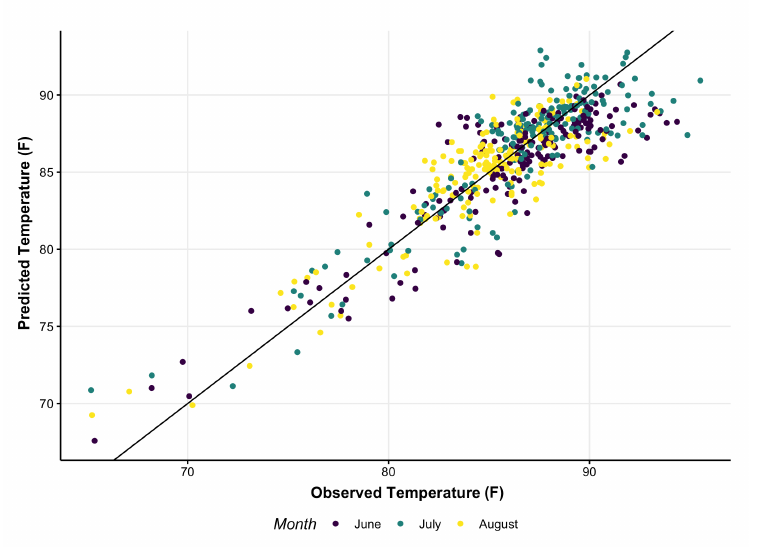
Figure 3. Observed monthly average maximum daily temperature records at withheld climate-data stations versus model